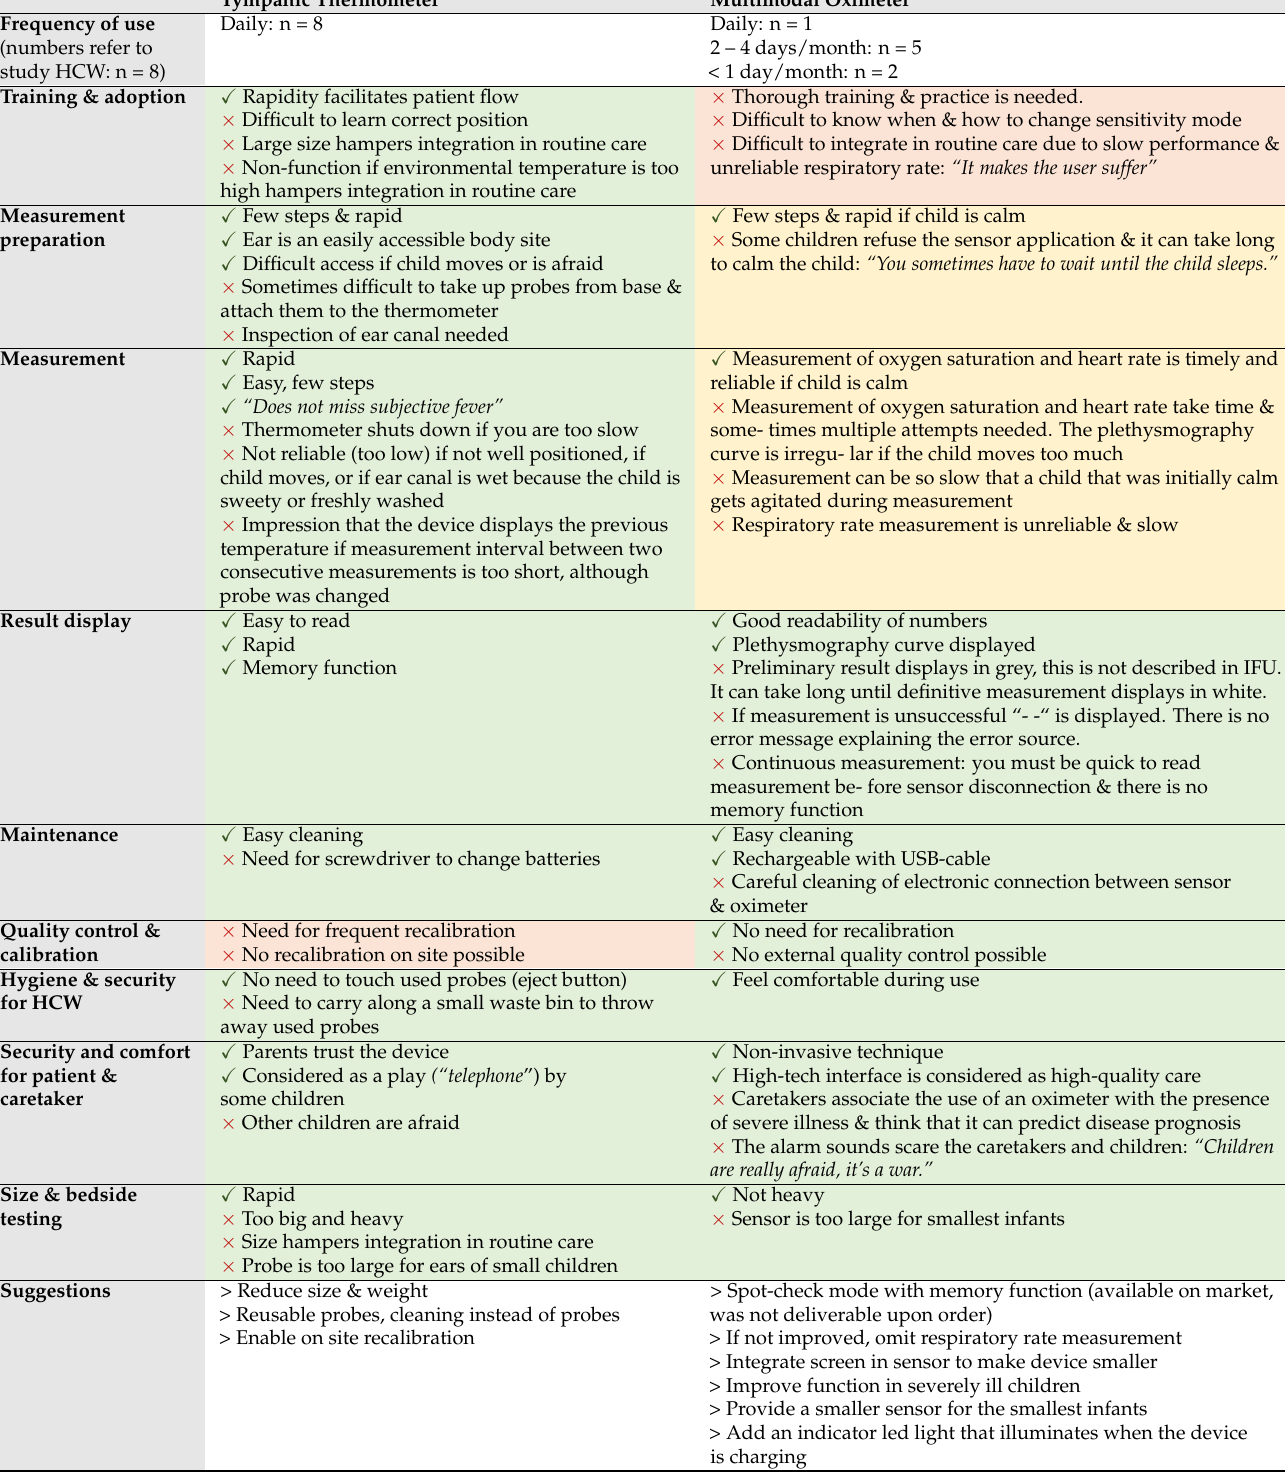
Table 2. Usability evaluation based on a semi-structured interview of end-users along the lifecycle of handheld diagnostic devices to measure tympanic temperature and respiratory rate. Legend: HCW: healthcare workers, caretaker: parent or other person taking care of the child upon admission. Tympanic Thermometer Multimodal Oximeter Frequency of